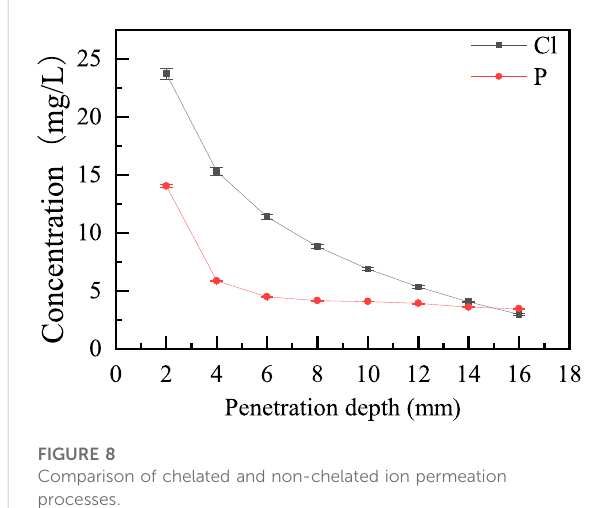
FIGURE 7 Chelating agent penetration processes at different concentrations.